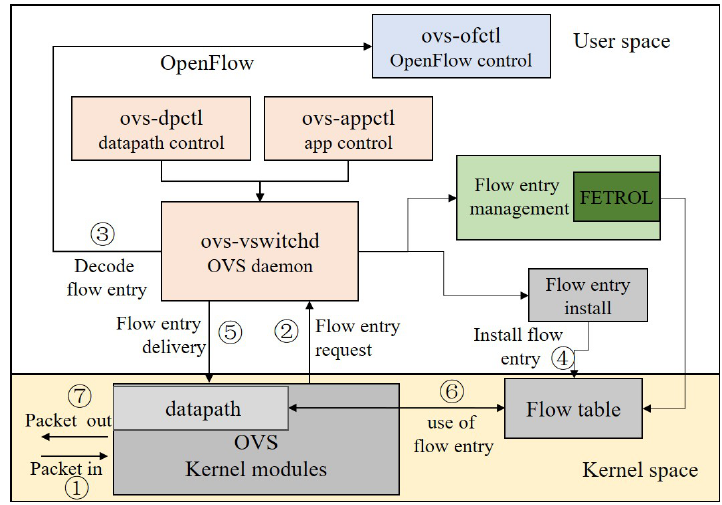
Figure 5. The structure of OpenVSwitch.